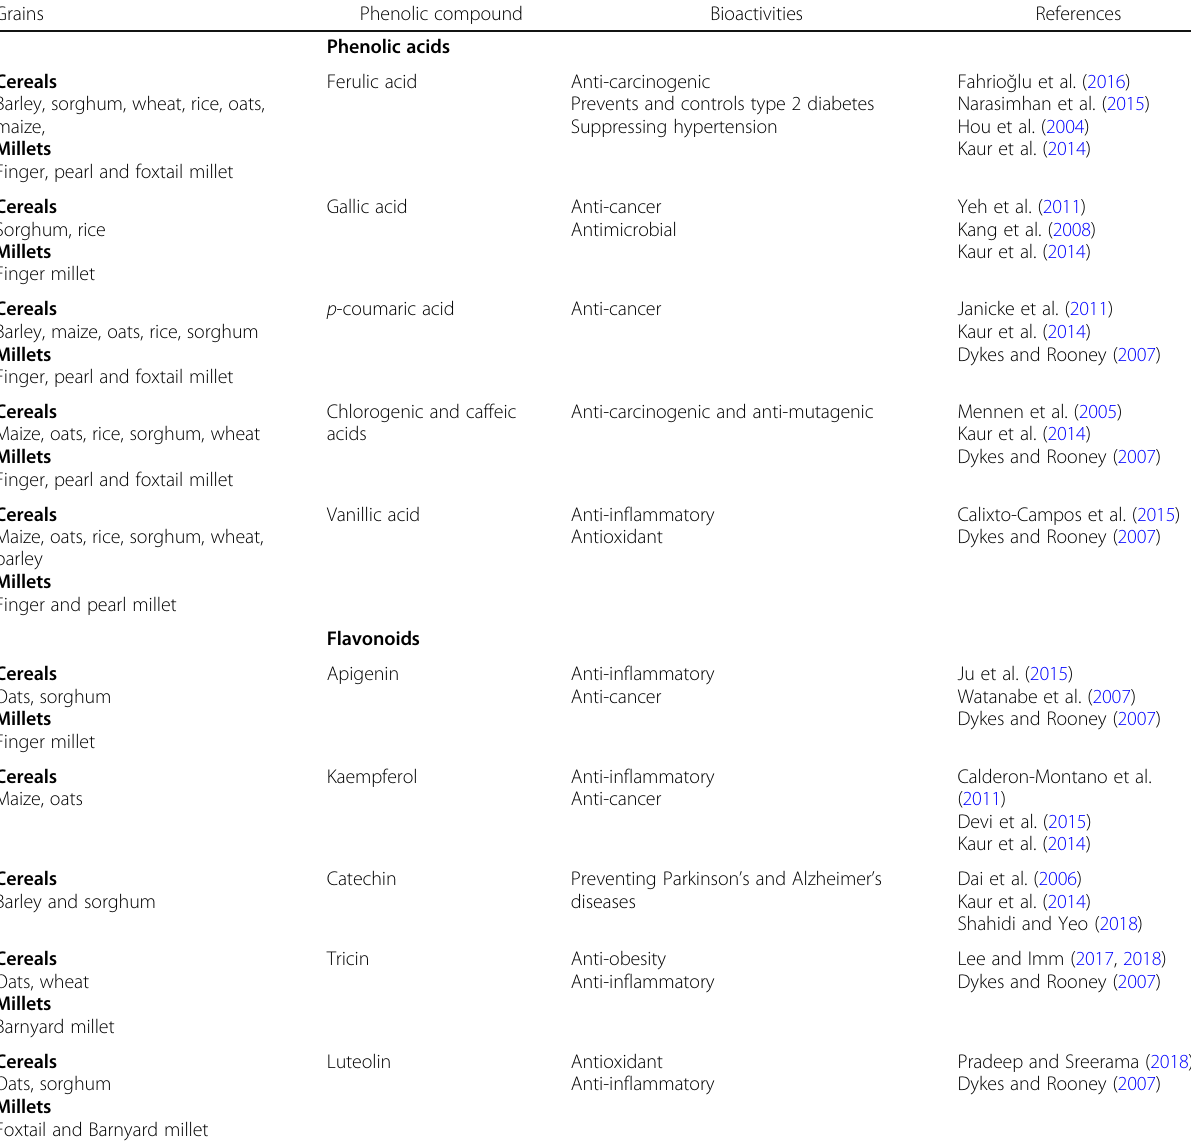
Table 2 Bioactivities of phenolic acids and flavonoids in different cereal and millet grains